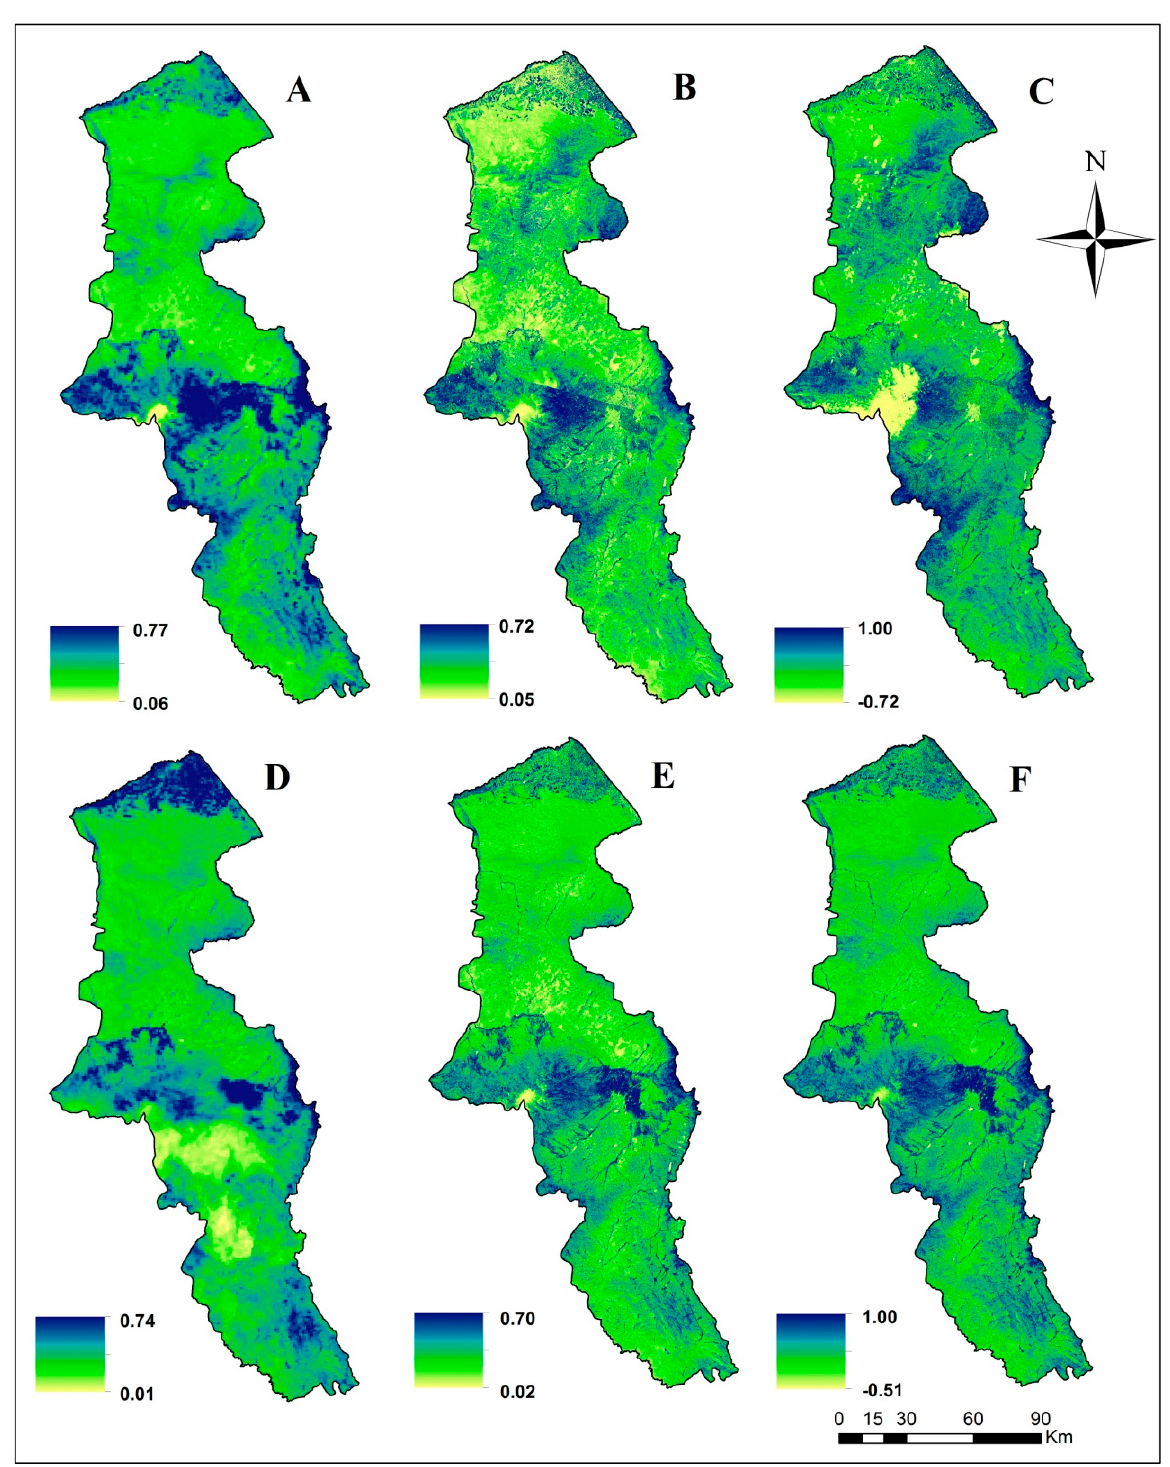
Figure 4. Maps of vegetation indices produced from GEE and ENVI 5.3 in June (up) and July (down) 2020 ( A : EVI G (June), B : EVI E (June), C : NDVI E (June), D : EVI G (July), E : EVI E (July), F : NDVI E (July)).